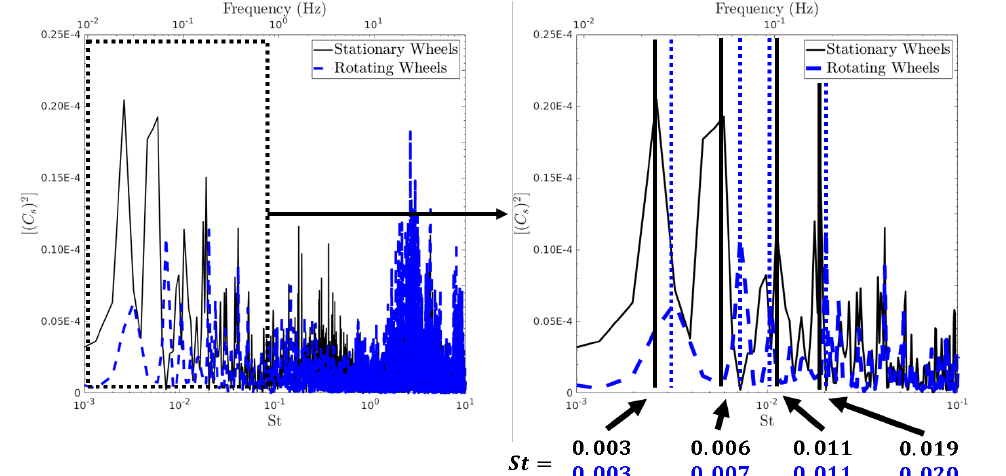
Figure 10. Pre-multiplied power spectral density (PPSD) of the side-force coefficient C S for the stationary (black line) and rotating (blue-dashed line) wheels